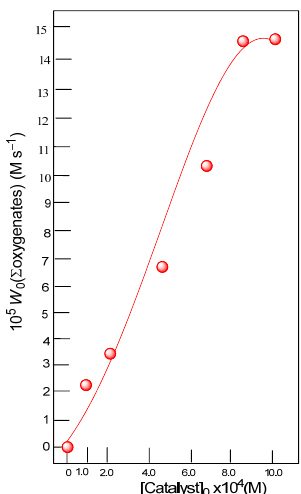
Figure 6. Dependence of the initial rate of oxygenate (sum cyclohexanol+cyclohexanone) formation W 0 for complex 3 on the initial concentration of catalyst.